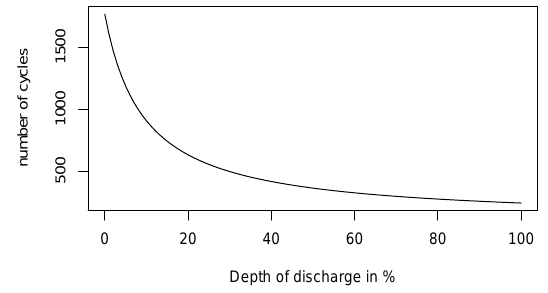
Figure 1. Typical relationship between battery life and depth of